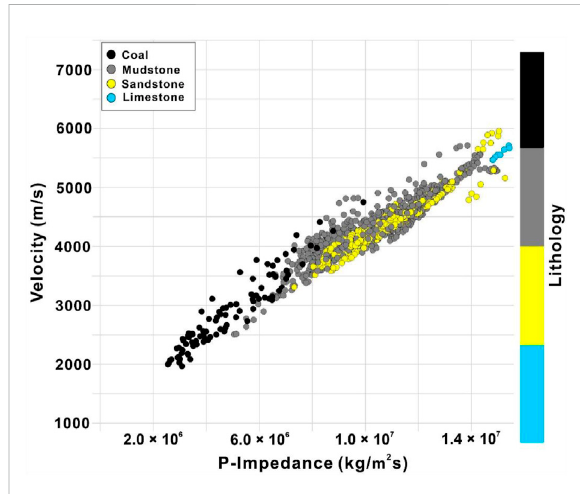
FIGURE 3 Crossplot of ZOI of well J32 showing the p-velocity and p-impedance presenting the different lithofacies in the Hangjinqi area. Coal showed low velocity and low impedance, limestone showed high velocity and high impedance. Mudstone and sandstone show overlapping, but mudstone shows lower impedance as compared to tight